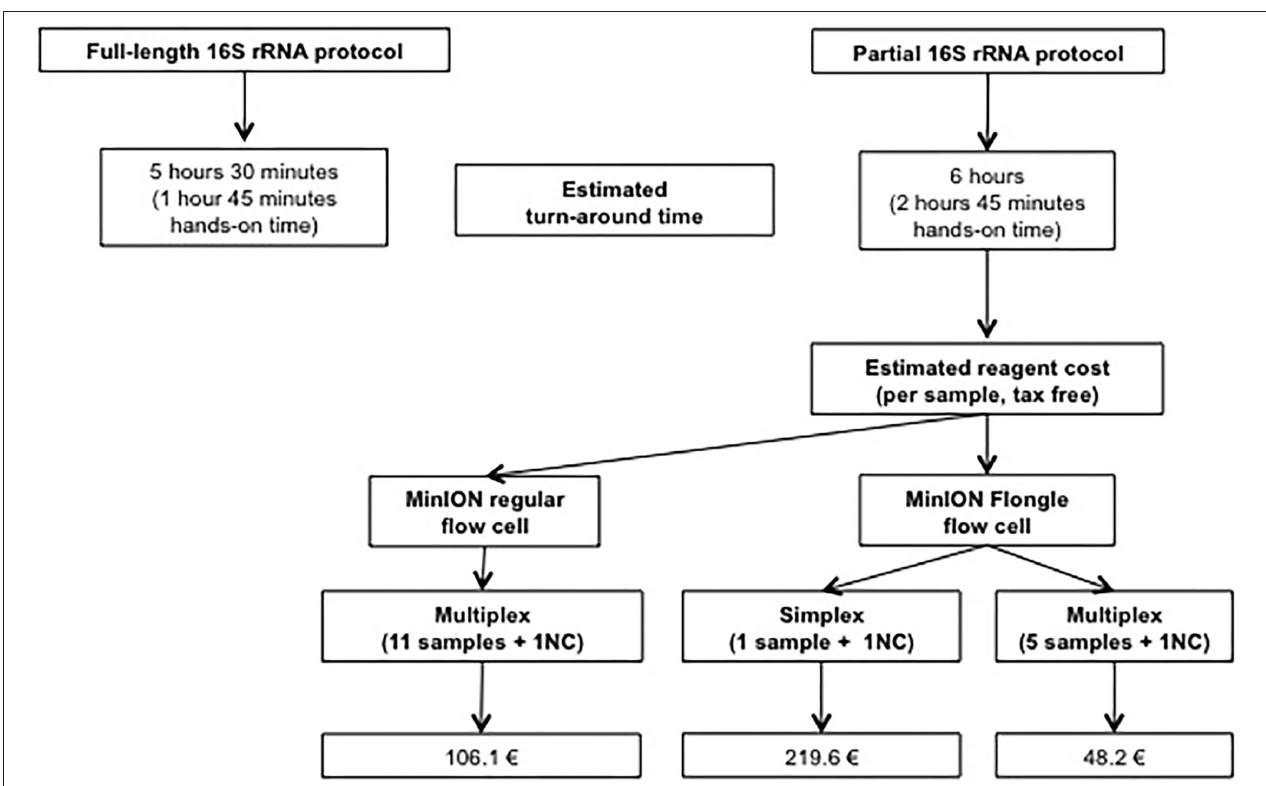
FIGURE 3 | Comparison of Estimated Total Time and Reagent Cost of 16S rRNA Nanopore